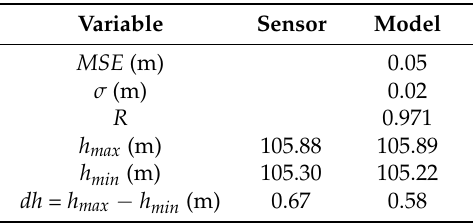
Table 1. Model errors; MSE denotes Mean Squared Error, σ standard deviation, R correlation coefficient, h max maximum water level, h min minimum water